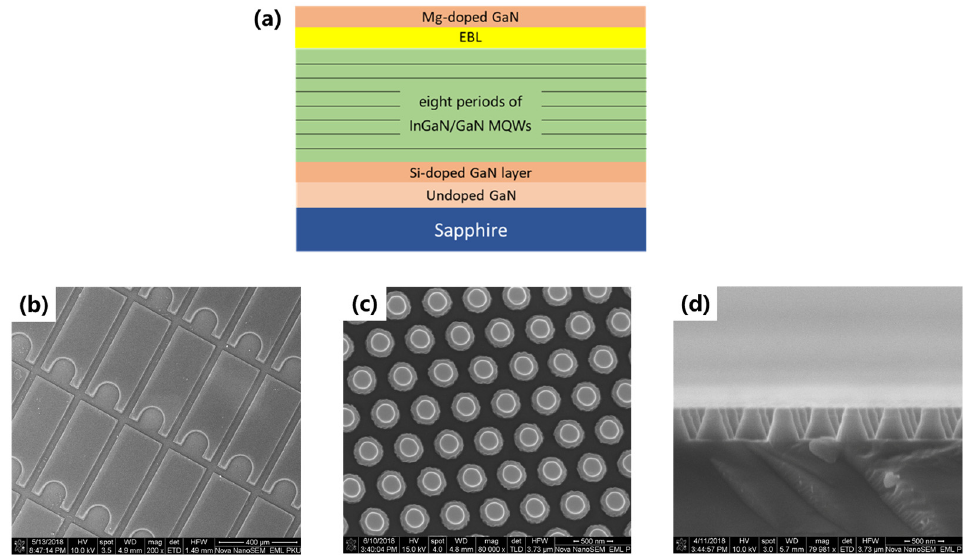
Figure 1. ( a ) The structure of InGaN/GaN MQW green LEDs; ( b ) top-view SEM image of conven- tional LEDs; ( c ) top-view SEM image of nanorod-array LEDs; ( d ) side-view SEM image of nanorod array LEDs.